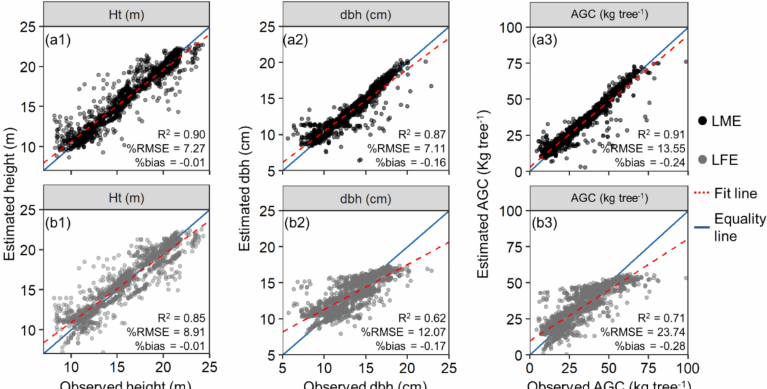
Figure 7. Field measured (observed) and leave-one-out cross-validation (LOOCV) estimated tree attributes using linear fixed- and mixed-e ff ects models ( a , b , respectively) with the SID as a random-e ff ect variable. LOOCV estimations for height (Ht), diameter at 1.3 m above the ground (dbh), and aboveground carbon (AGC) ( a1 , b1 , a2 , b2 , a3 , b3 , respectively). The red dashed line presents the fit between observed and estimated values, and the blue line is the equality line (intercept = 0, slope = 1).